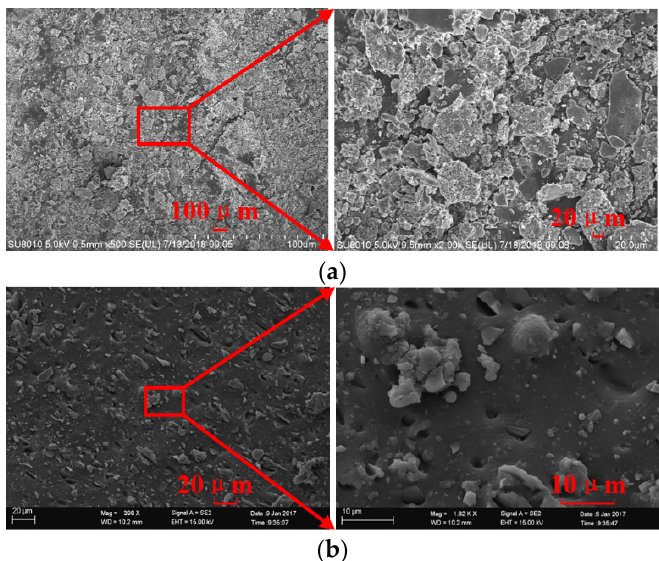
Figure 19. Microscopic appearance of silicone rubber: ( a ) Surface layer; ( b ) Inner layer.